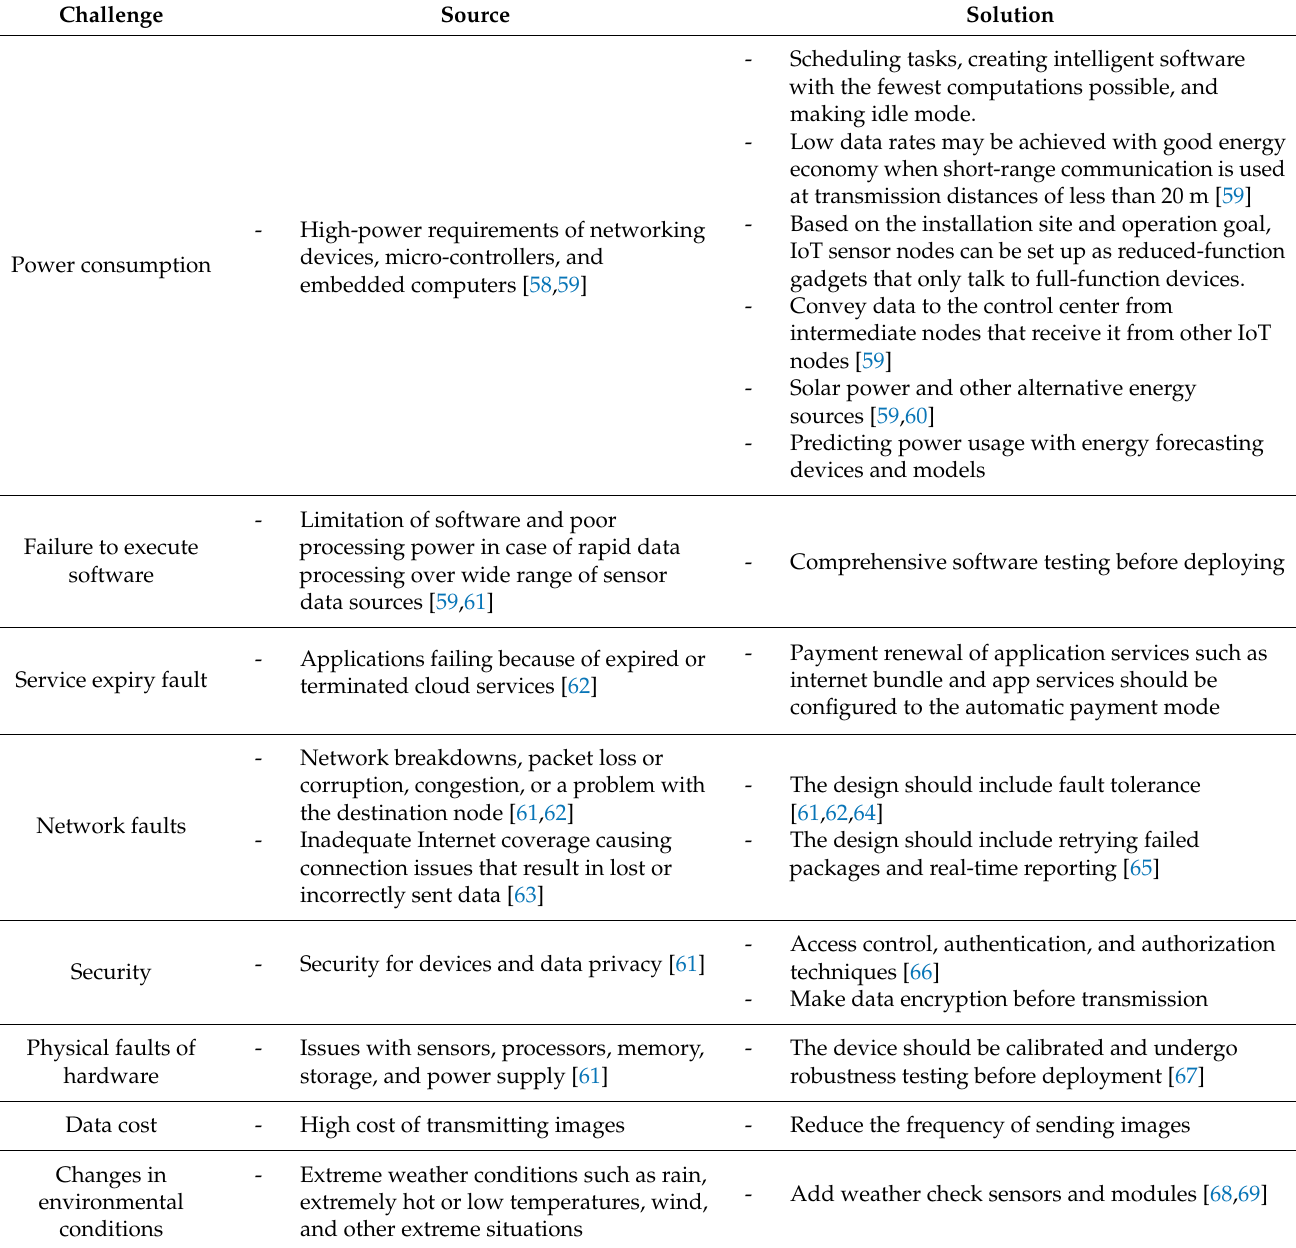
Table 4. Challenges of artificial intelligent field devices, sources, and proposed